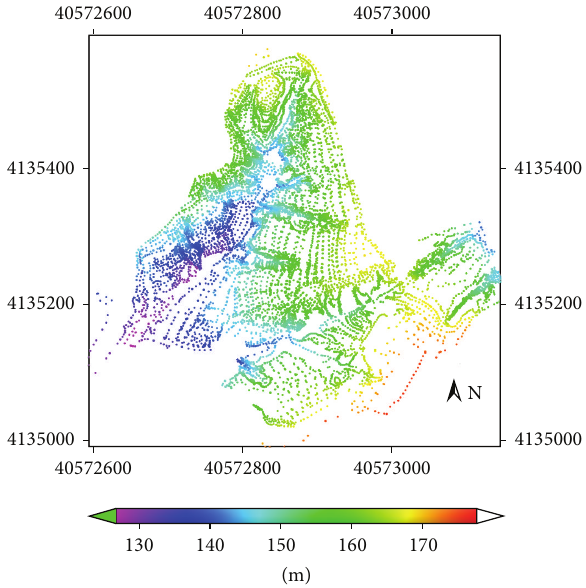
Figure 2: Distribution of RTK-GPS measured points in study area.